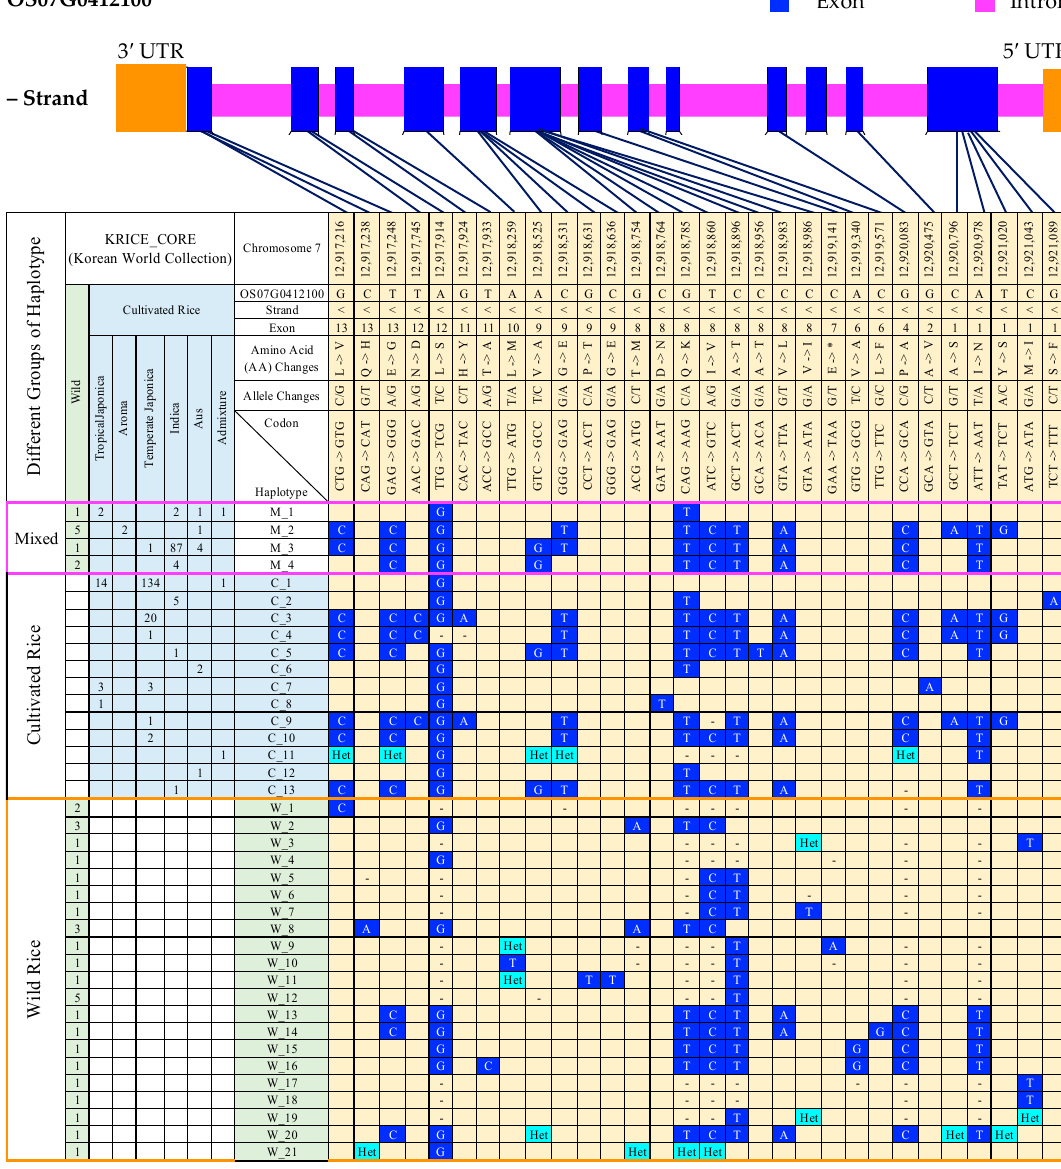
Figure 1. Gene structure and haplotype analysis of the GBSSII ( Os07g0412100 ) gene in the 475 Korean rice accessions. Light-blue (cultivated) and pale-green-colored (wild) columns provide the list of haplotypes together with their respective number of rice accessions in each subpopulation. Blue cells indicate all SNP variations (minor alleles) found only at nonsynonymous mutation sites. Blank cells indicate major alleles or the same nucleotide to that of the reference. Cyan color, “Het”, refers to “heterozygote”, and the “dash (-)” indicate a position for an “unknown” nucleotide or generally refers to “N” (any nucleotide A, T, G, or C). C: cultivated rice, W: wild rice, M: a combination of cultivated and wild rice. Note: The selected number of chromosome positions and sorted haplotypes were based on the identifications where nonsynonymous substitutions (nsSNPs) or functional substitutions were observed.